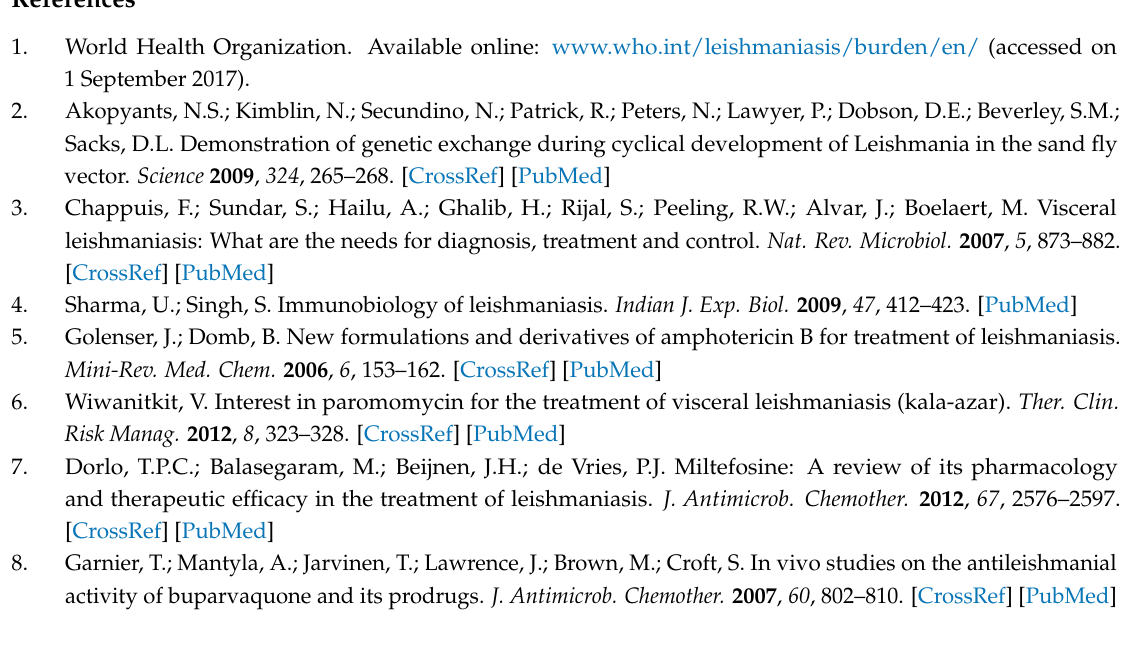
Supplementary Materials: The following are available online, the structure data of all maleimides and the biological methods in